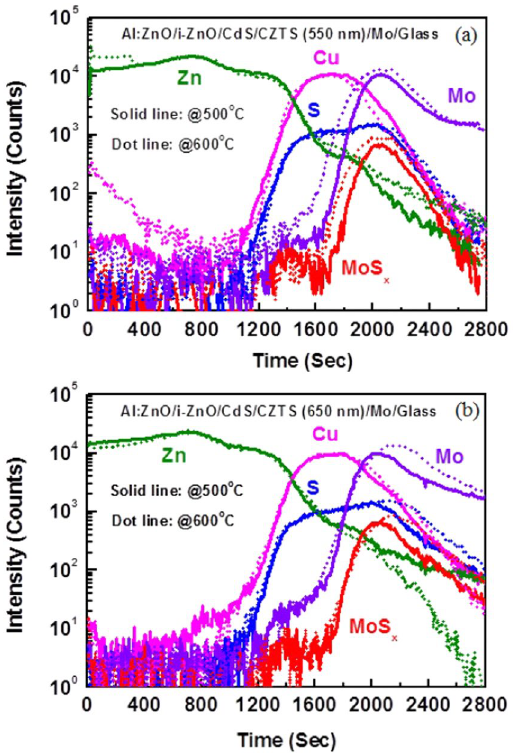
Figure 7. SIMS profile of elemental atoms from Al:ZnO/i-ZnO/CdS/CZTS/Mo/Glass structures with CZTS absorber layer thickness of ( a ) 550 nm and ( b ) 650 nm.